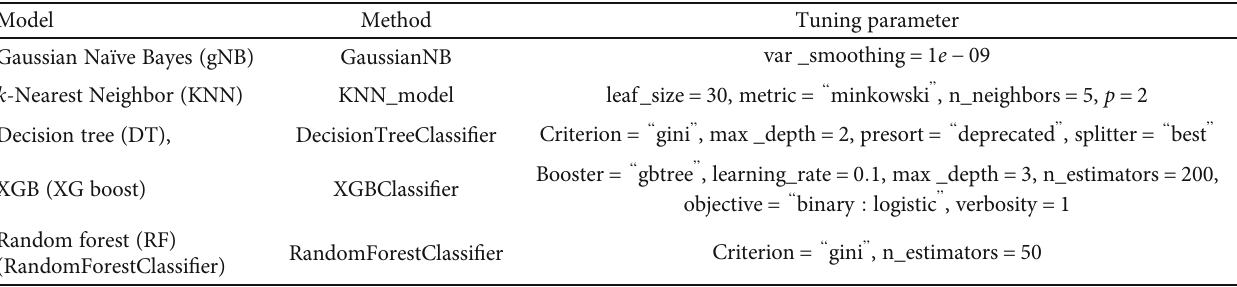
Table 1: Tuning parameters of the machine learning models.